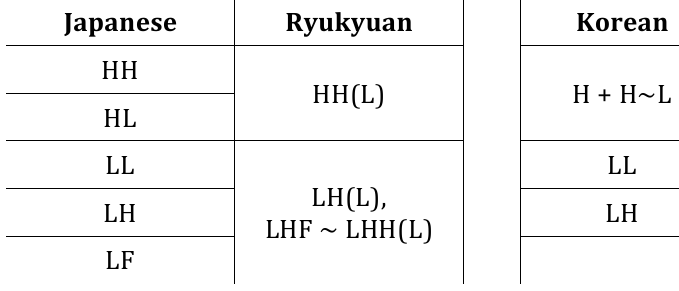
Table 9: A comparison of Japanese pitch accent, Ryukyuan pitch accent and Korean